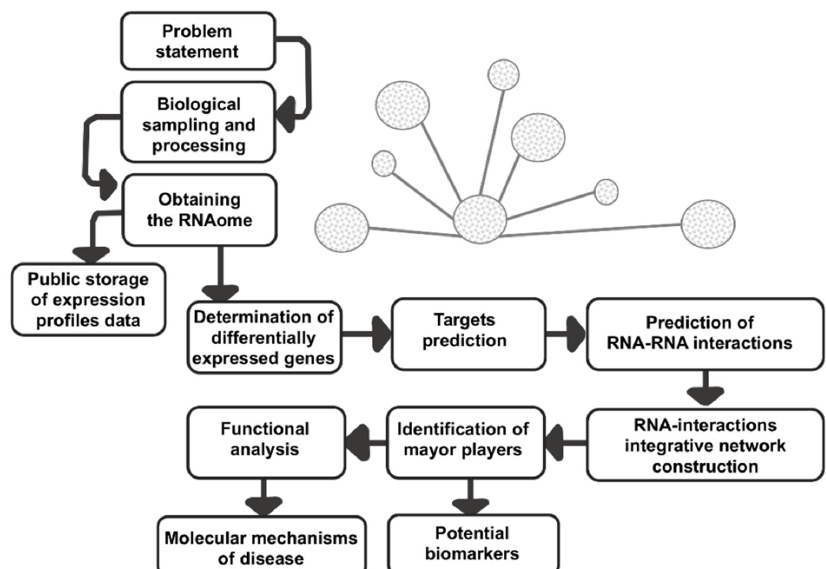
Figure 1. Flowchart of a typical ncRNAs-interactions network analysis. RNAome can be obtained from RNA-seq or microarrays analysis, and from databases such as The Cancer Genome Atlas (TCGA) or Gene Expression Omnibus (GEO). The prediction of gene targets is routinely performed with programs such as lncRNASNP, miRsponge, NONCODE, miRmine, starBase, and PeTMbase, etc. The prediction of lncRNAs-miRNAs-mRNAs interactions networks can be built using computational programs, typically Cytoscape. Subsequently, the gene ontology analysis can be performed in order to identify genetic pathways and altered cellular functions. Finally, the experimental validation is a necessary step to obtain a more complete portrait of ncRNAs interplay resulting in specific cancer